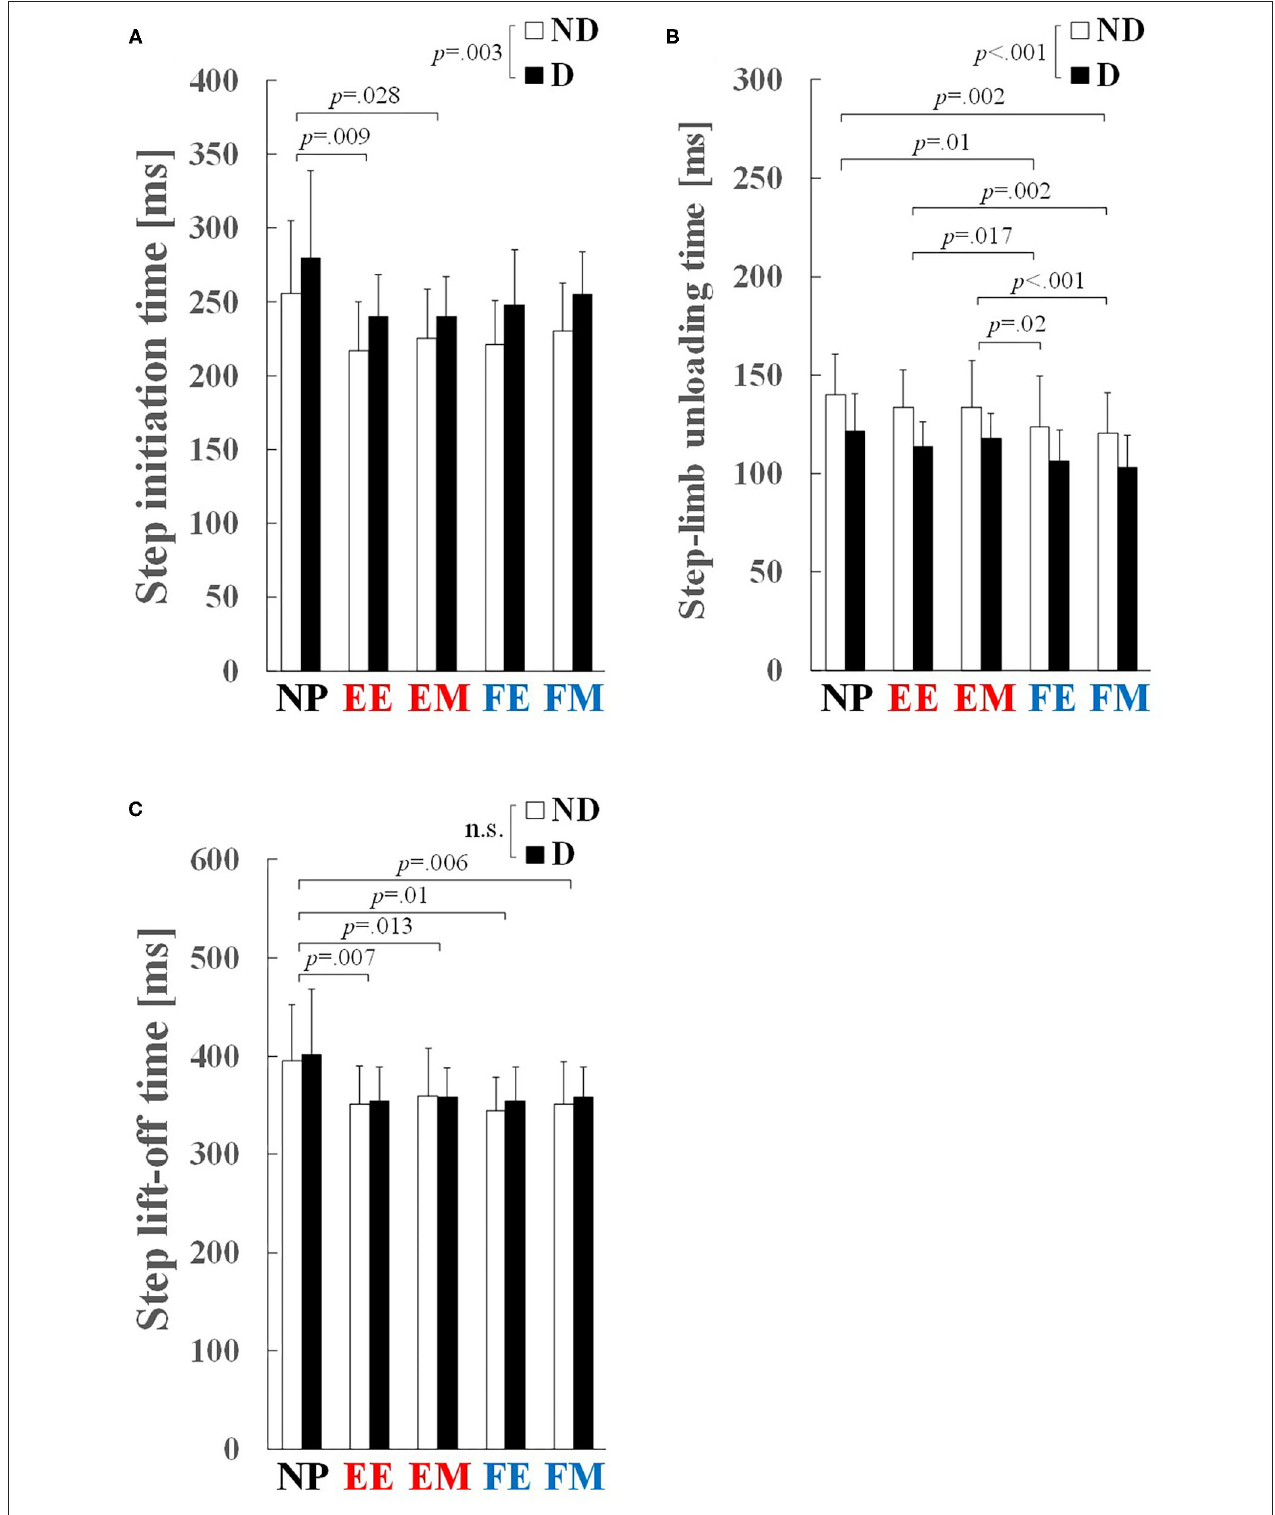
FIGURE 4 | Step-initiation characteristics: (A) step initiation time, (B) step-limb unloading time, and (C) step lift-off time. Values and error bars are mean and SD. EE and EM, early and middle phases of the knee extension phase; FE and FM, early and middle phases of the knee flexion phase; ND, non-dominant; D, dominant.